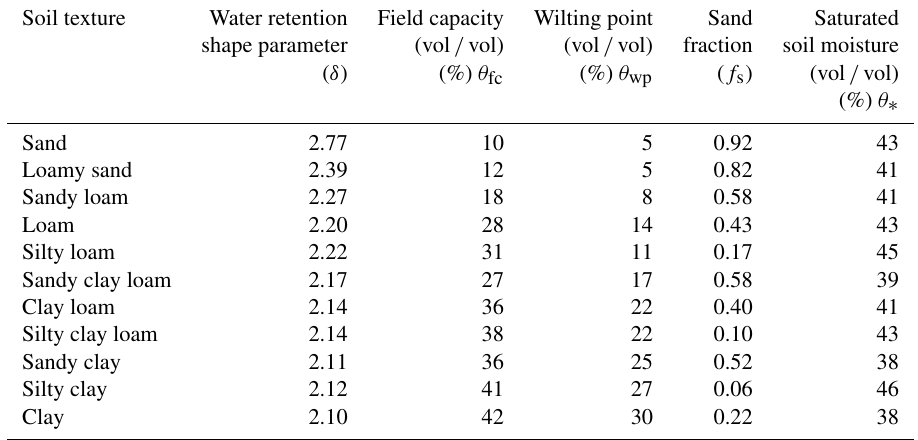
Table E1. Soil textural properties and their values used in the present study (Murray and Verhoef, 2007; Minasny and Hartemink, 2011; Anderson et al.,